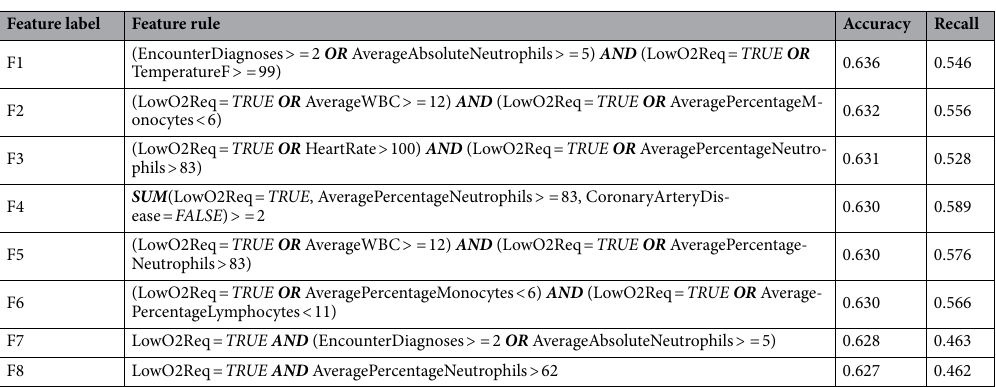
Table 2. The most accurate engineered features (short Boolean rules) found by the rule-learning algorithm.